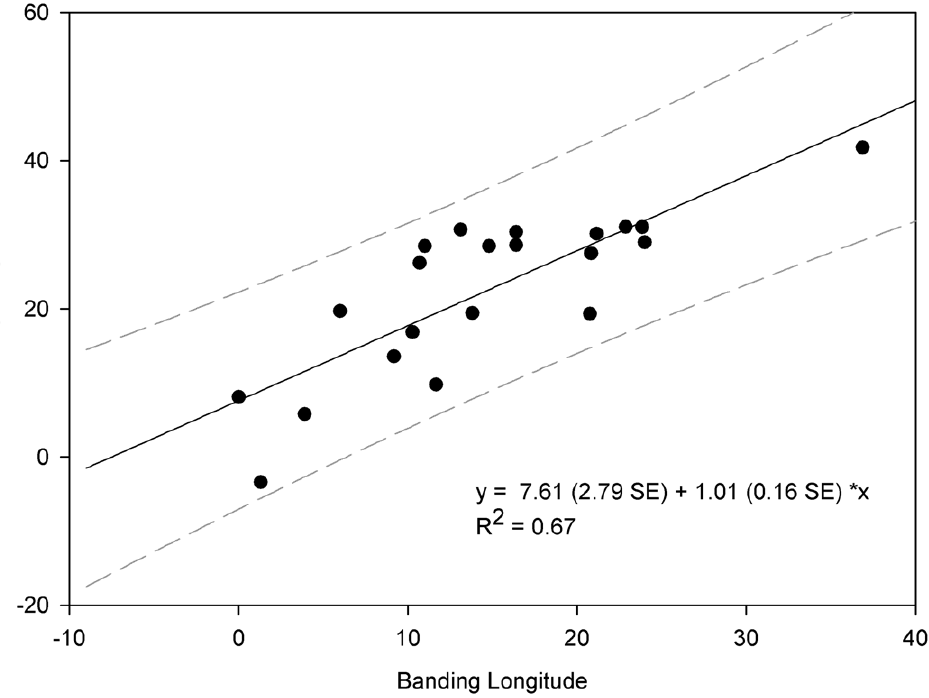
Figure 2. Relationship between longitude of ringing versus longitude of recovery for 21 trans-Sahara house martin ring-recoveries. Ordinary least squares regression is shown (solid line) with 95% prediction intervals (gray